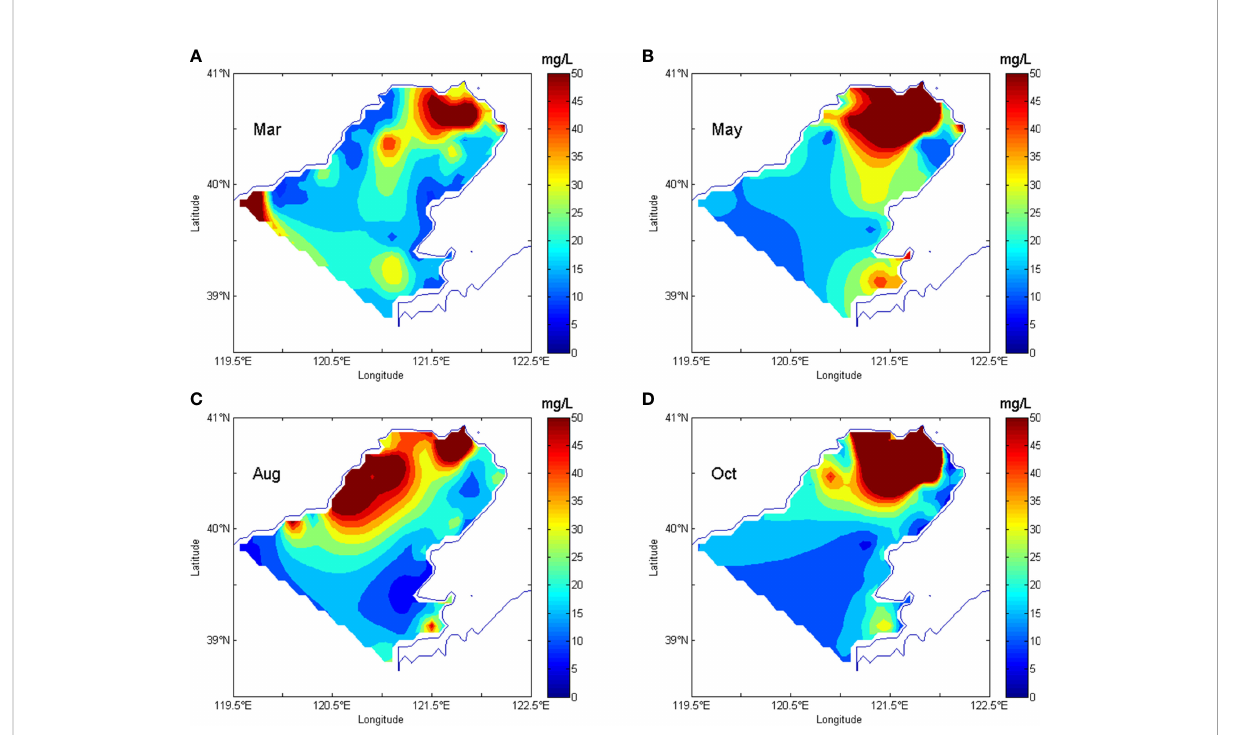
FIGURE 7 Interpolated distributions of SPM concentrations in the Liaodong Bay using RBF interpolation. (A) is the distribution obtained by RBF interpolation based on SPM observations in March 2015. (B – D) are the interpolated distributions of May, August and October 2015, respectively.